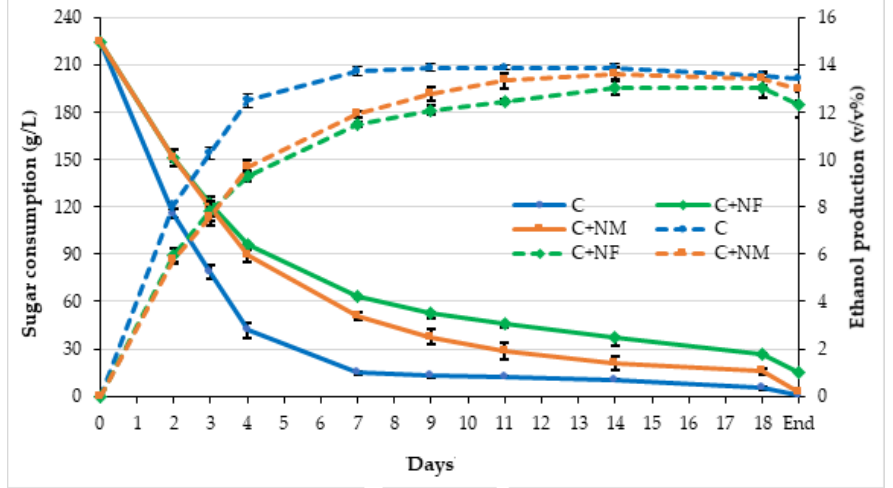
Figure 2. Kinetics of sugar consumption (solid lines) and ethanol production (dashed lines) in the three fermentation conditions. C — control fermentation, inoculated with EC1118; C + NF — mixed starter EC1118 + ND1 as free cells; C + NM — mixed starter EC1118 + ND1 as microencapsulated cells; End — last fermentation day, variable for each starter. Data are the means of triplicate experiments ± standard deviation.